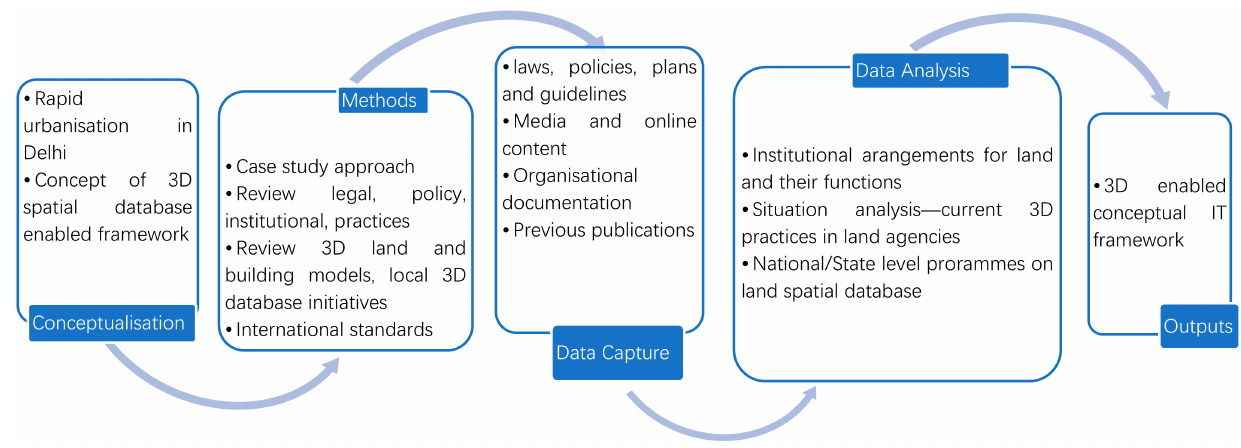
Figure 1. Methodology